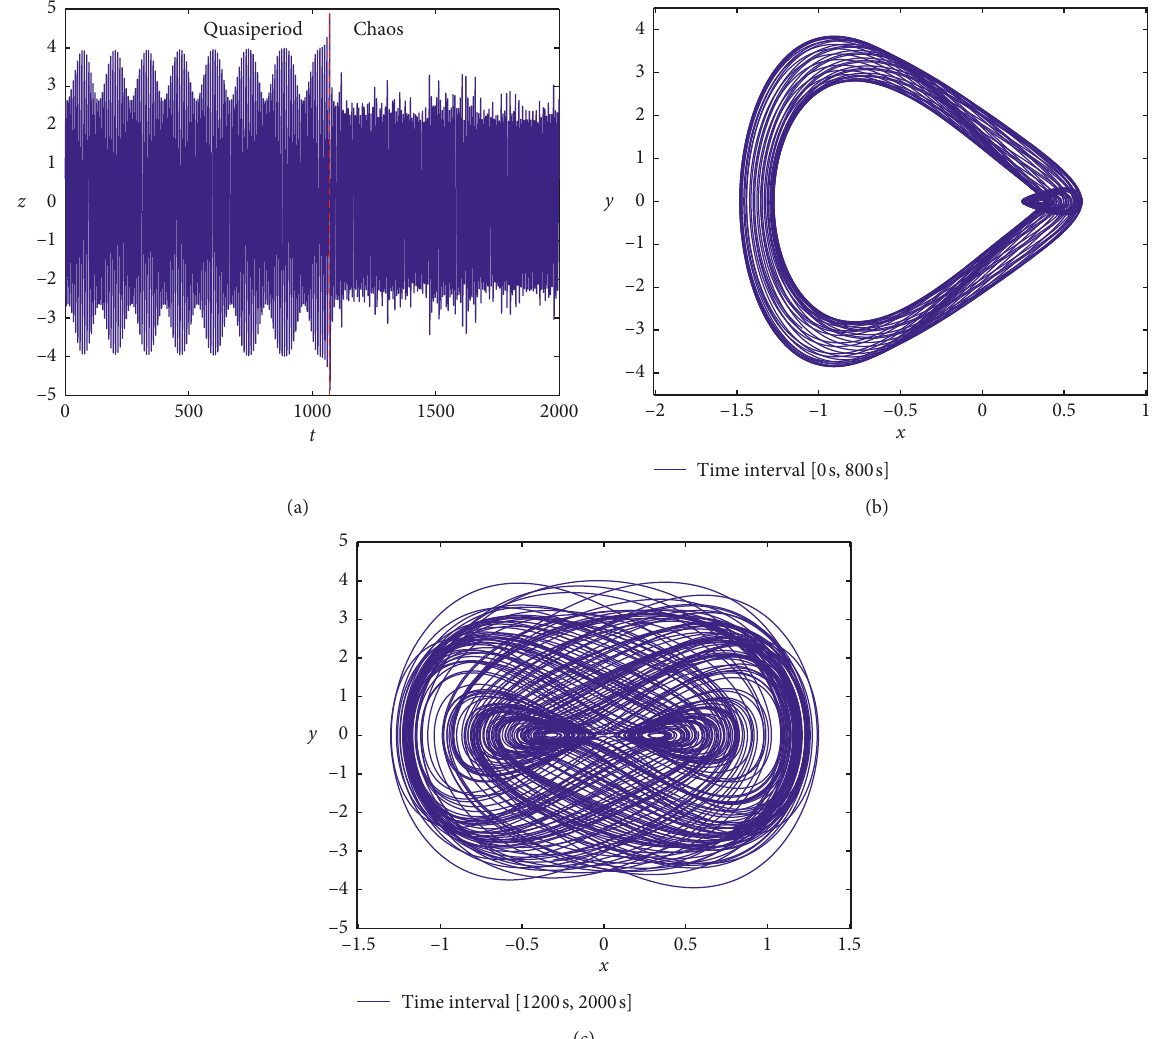
Figure 9: (a) Time-domain waveform of z in the region of [0 s, 2000s]; (b) the phase portrait in time interval of [0s, 900s]; (c) the phase portrait in time interval of [1100s,